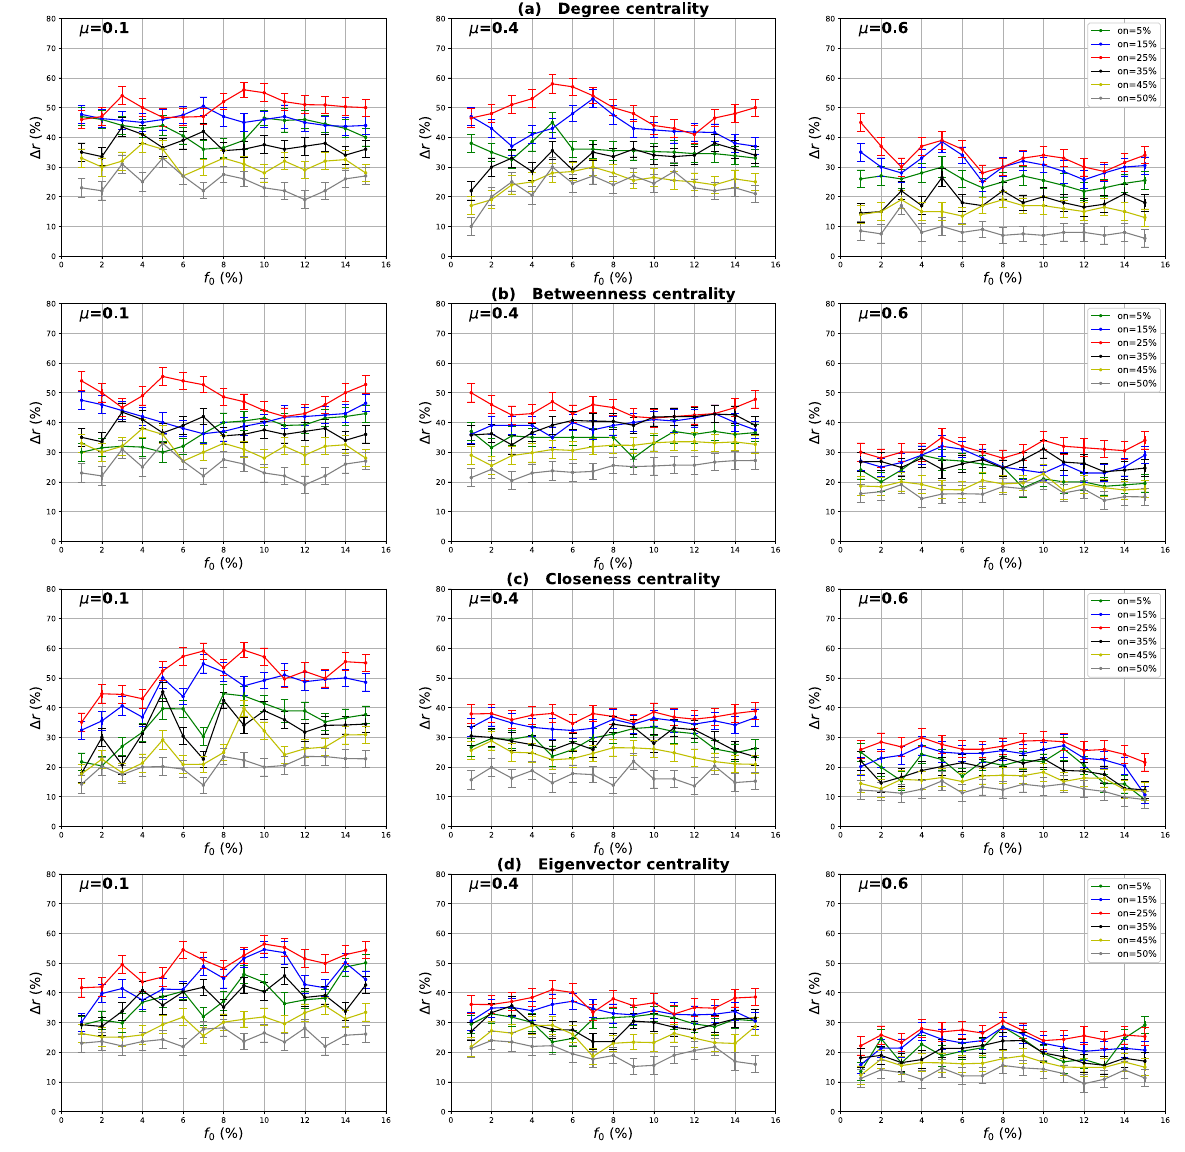
Figure 6. Influence of the number of overlapping nodes. The relative difference of the outbreak size Δ r between the standard measure and the modulus measure versus the percentage of initial spreaders f 0 . The community membership value om is equal to 10% of the total number of